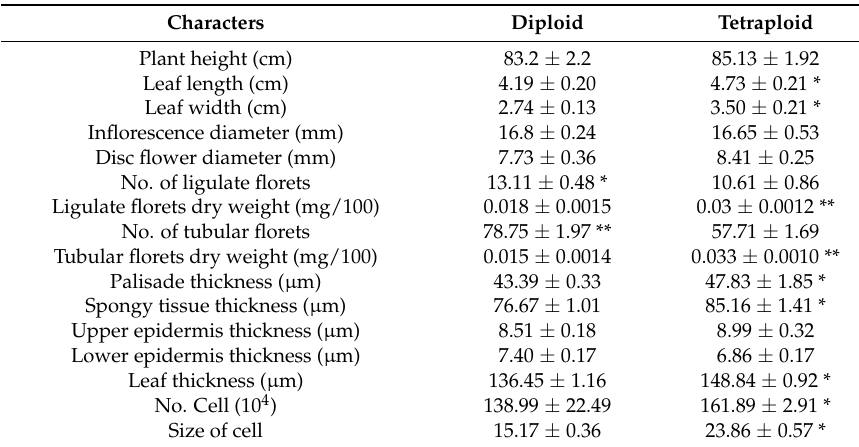
Table 1. Morphology of diploid and tetraploid Chrysanthemum lavandulifolium .